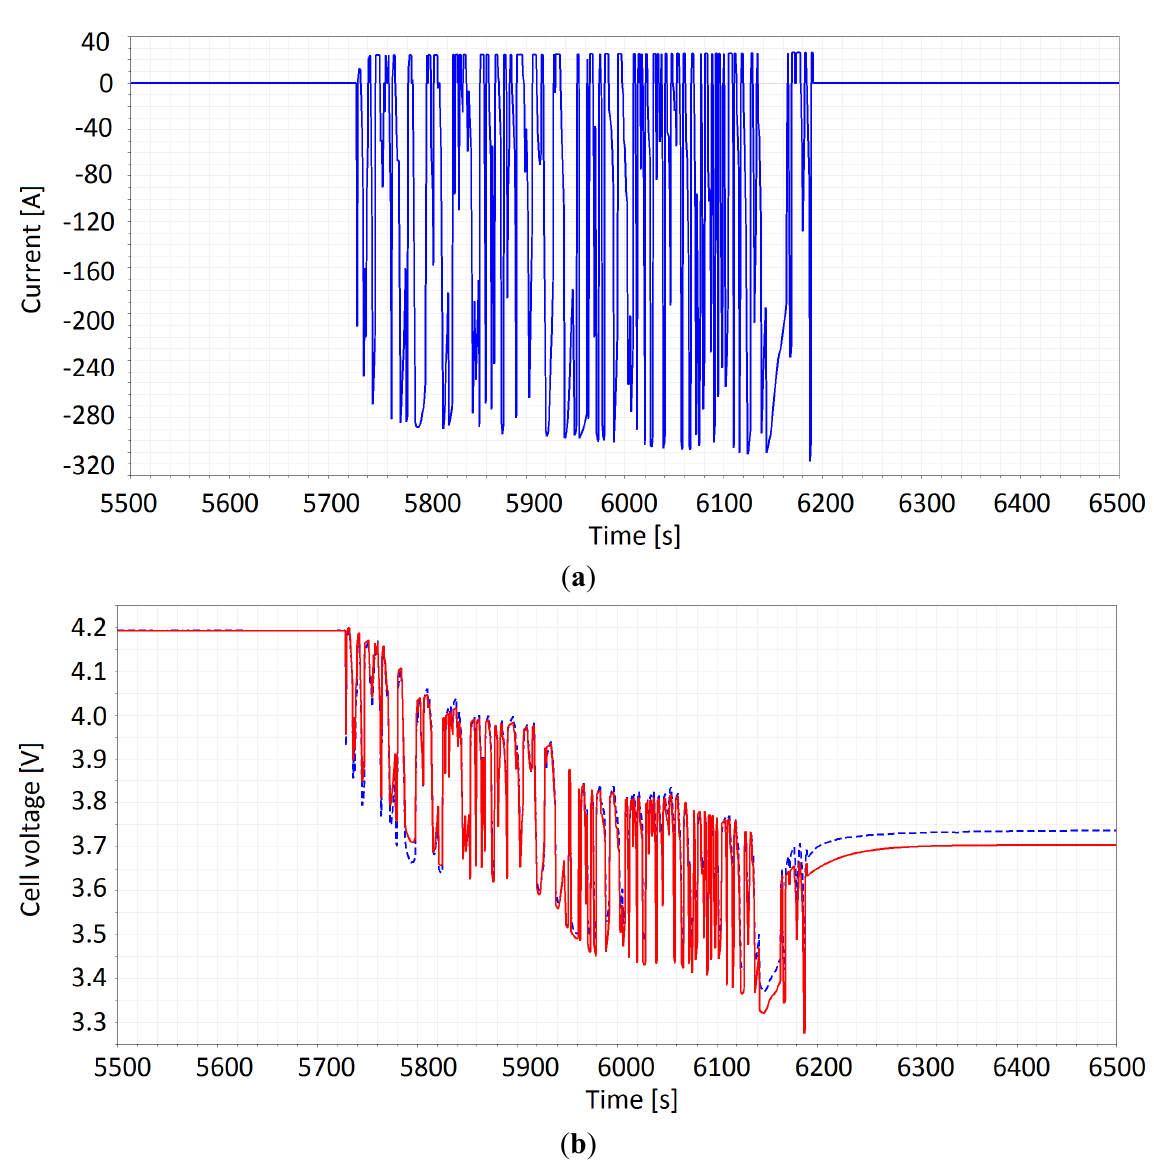
Figure 6. ( a ) Current profile used to test the 30 A·h NMC pouch cell; and ( b ) a comparison of predicted cycle voltage using the cell model (blue line) with actual test data (red line) for the 30 A·h NMC